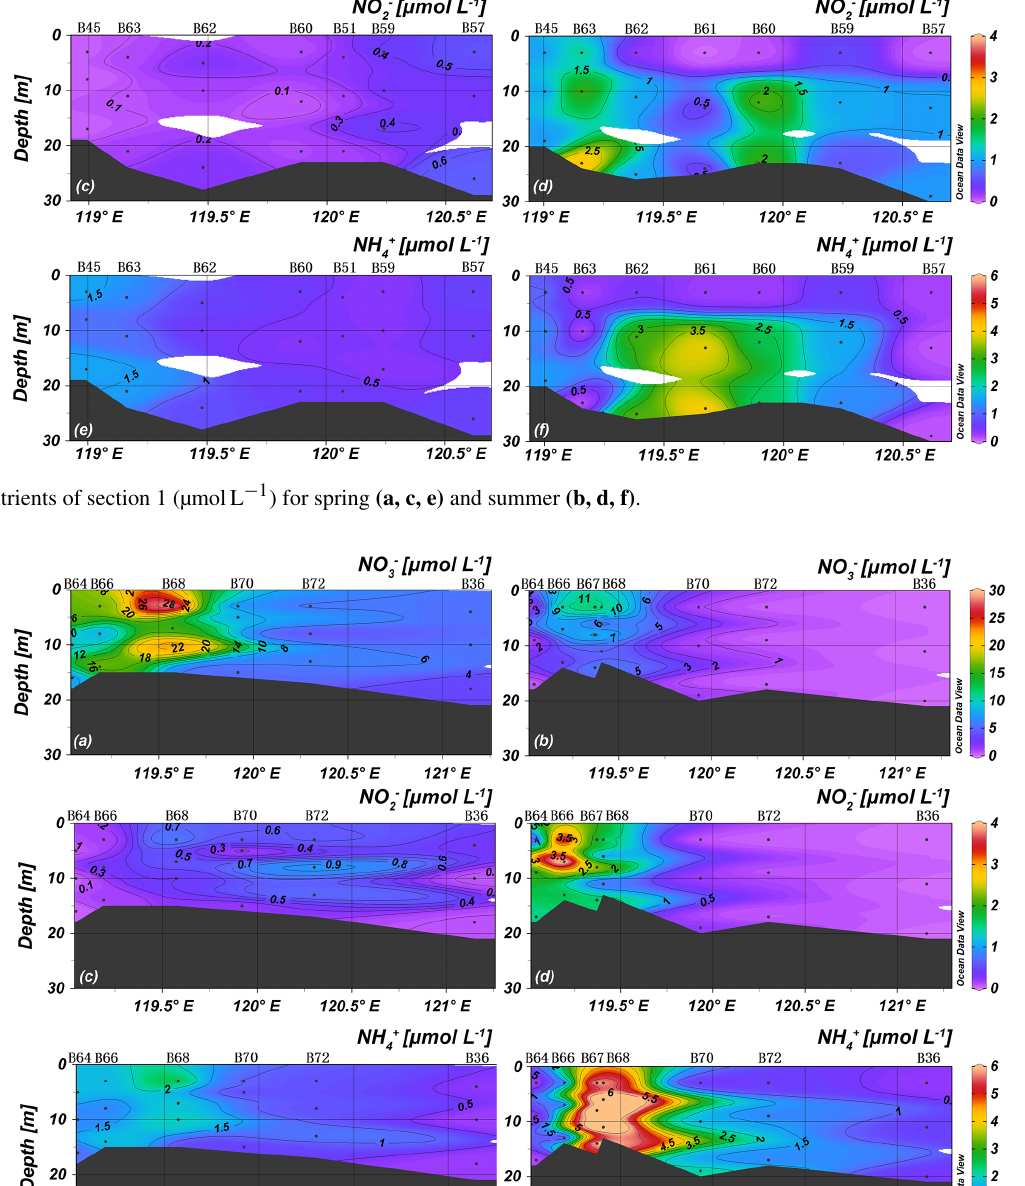
Biogeosciences, 19, 2397–2415,